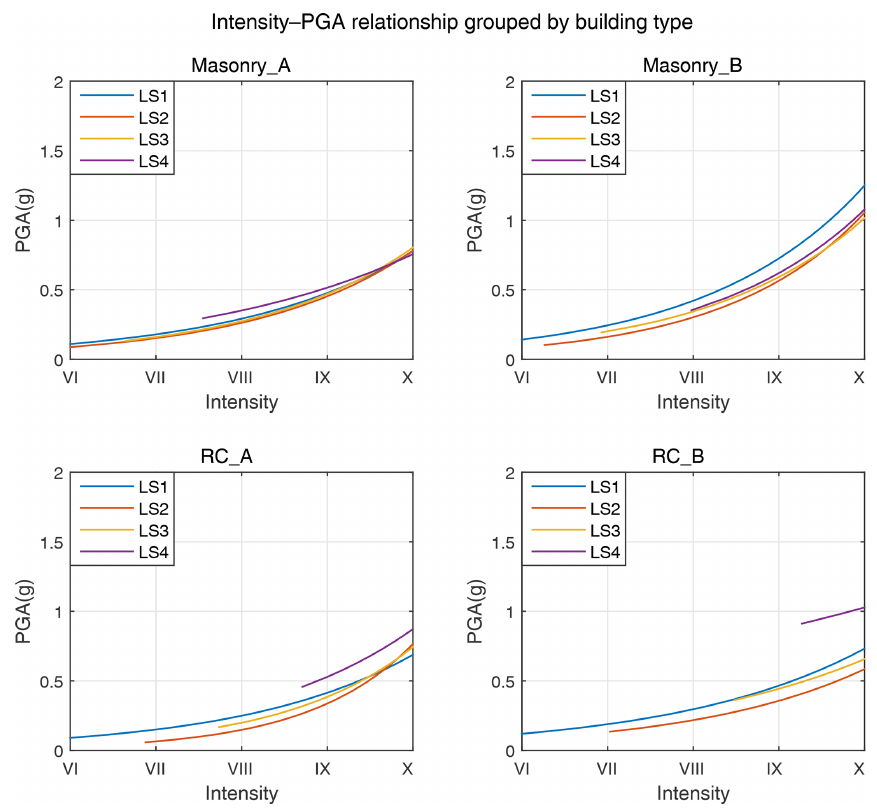
Figure 9. Intensity–PGA relations grouped by building types. Only intensity and PGA values with truncated exceedance probability ≥ 1% for each damage limit state of each building type are plotted, since higher damage states can appear only for higher intensities or PGA values (see Sect. 5.2 for more details).